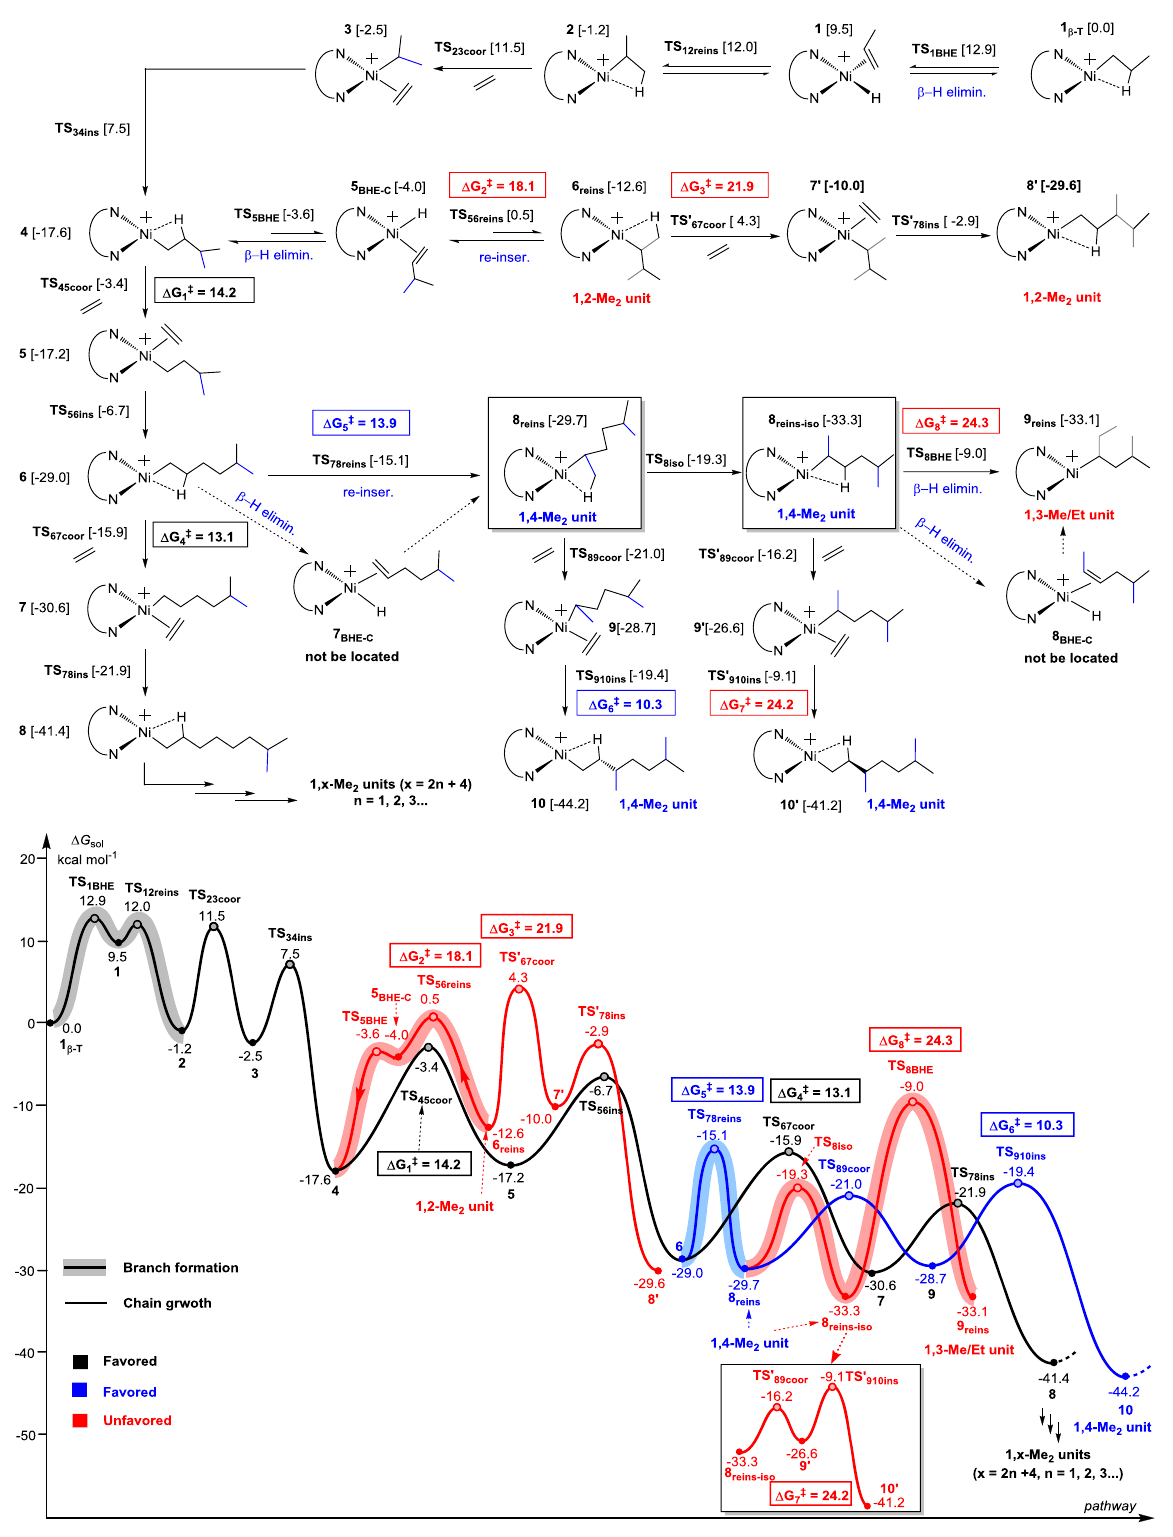
Fig. 5 Mechanism for the formation of branch generated by ipty-Ni from the DFT simulation. The mechanism involves the origin of selectivity, namely the inaccessible 1,2-Me 2 unit (distribution) and 1,3-Me/Et unit (longer branches) and the available 1,4-Me 2 unit. TS: transition state; BHE: β -H elimination; elimin.: elimination; reins: reinsertion; re-inser.: re-insertion; coor: coordination; ins: insertion; iso: isomerization; reins-iso: reinsertion-isomerization; BHE-C: β -H elimination-complex.